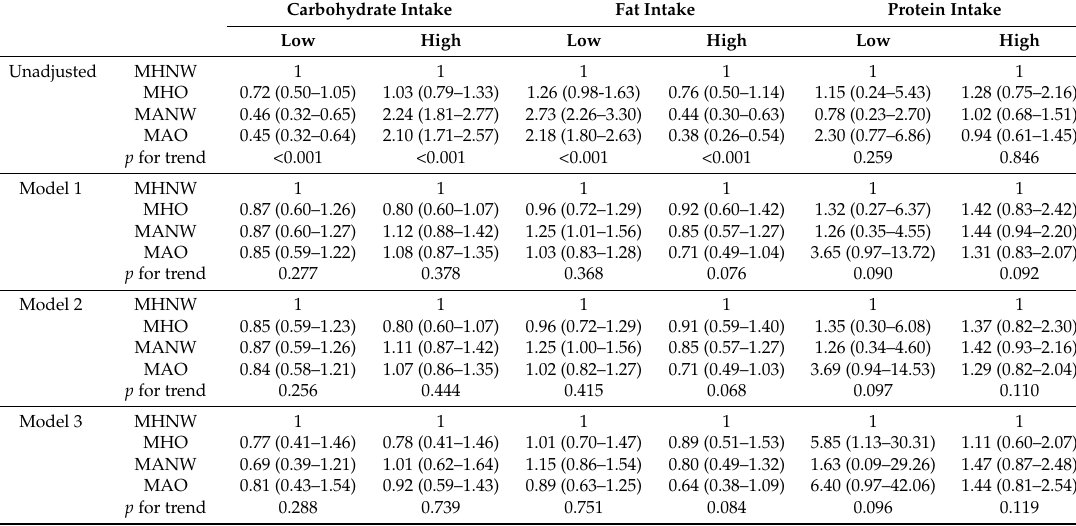
Table 4. Associations between high or low macronutrient intakes and the obesity/metabolic risk phenotypes in